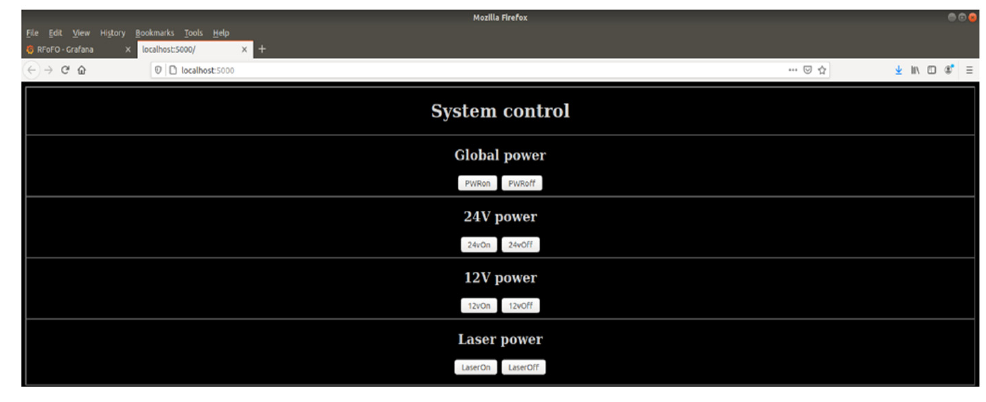
Figure 5. Control dashboard.